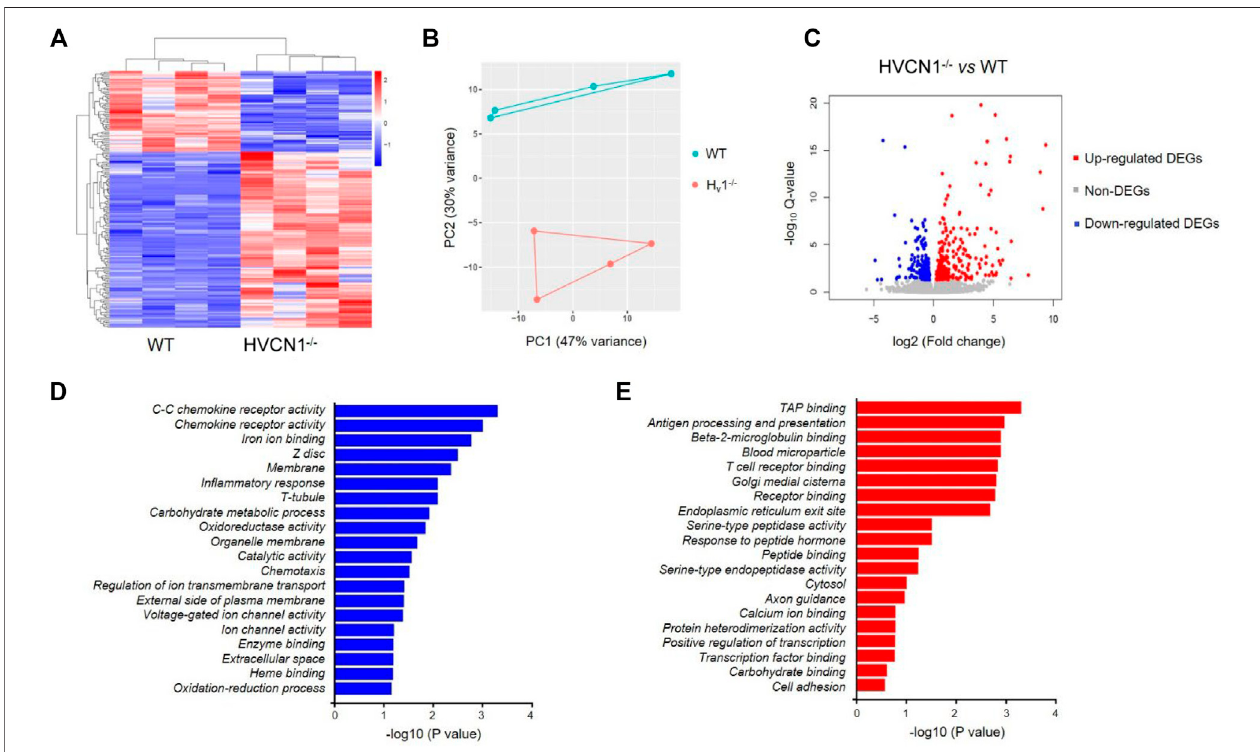
FIGURE1| RNAsequencinganalysisrevealedadifferentialtranscriptomepro fi leinHVCN1 − / − mouseheart. (A) HeatmapandhierarchicalclusteringofDEGsinthe wild-type and HVCN1 − / − hearts, n = 4 hearts for each group. (B) Principal component analysis of wild-type and HVCN1 − / − hearts. (C) The volcano plot has red points representing upregulated DEGs, blue representing downregulated DEGs, and gray points representing non-DEGs. (D-E) Gene Ontology enrichment analysis of top signi fi cant gene groups either downregulated (D) or upregulated (E) .